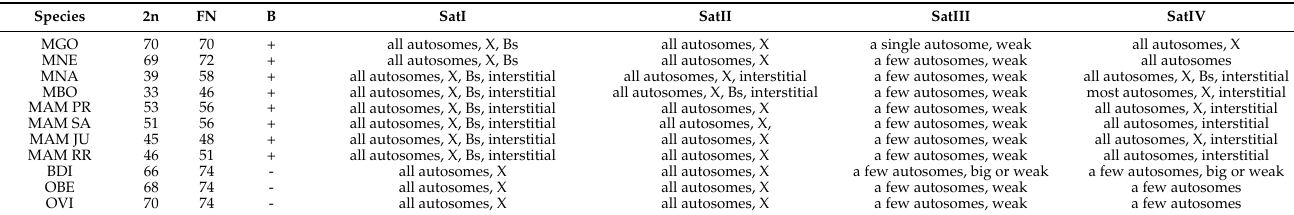
Table 4. Fluorescence in situ hybridization (FISH) patterns of the MGO satI-IV probes in Neotropical deer. Species